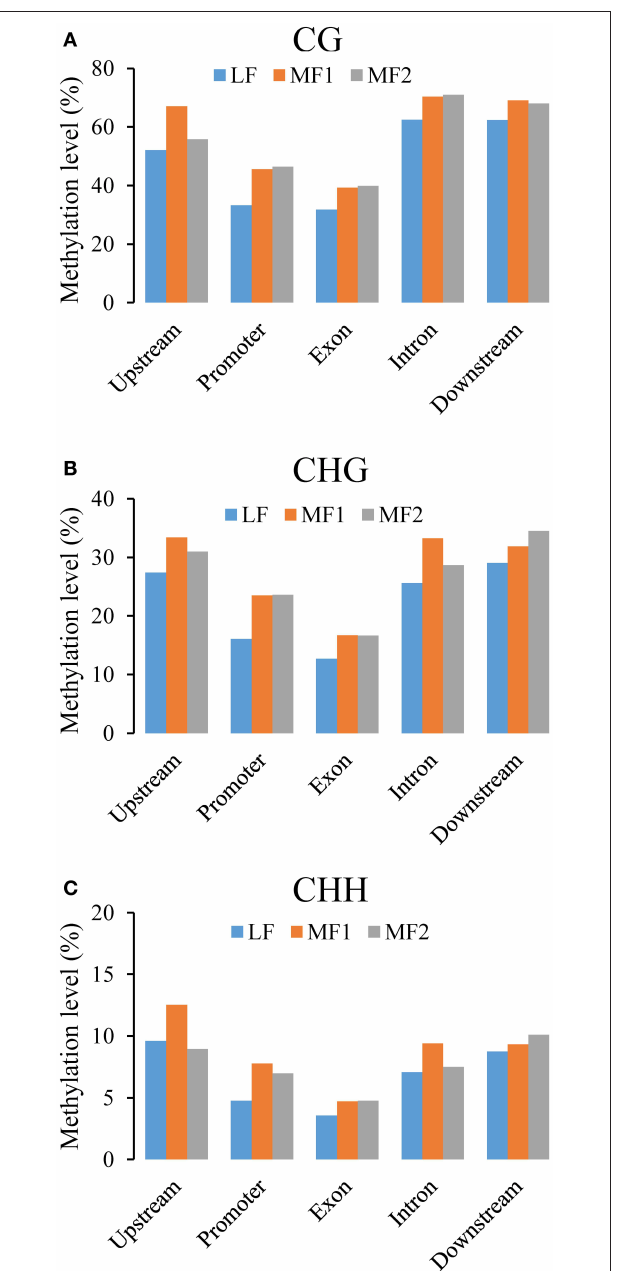
FIGURE 5 | Average methylation level in single-copy genes between three subgenomes for (A) CG, (B) CHG, and (C) CHH context. Whereas, promoter regions are defined as 200 bp regions before TSS site, upstream or downstream regions are defined as 1000 bp before TSS or after TTR sites.